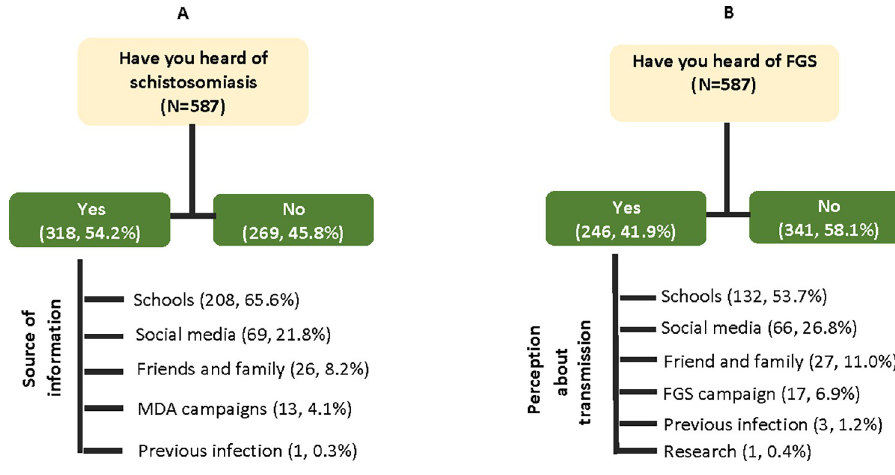
Fig 2. Awareness of schistosomiasis and FGS among university